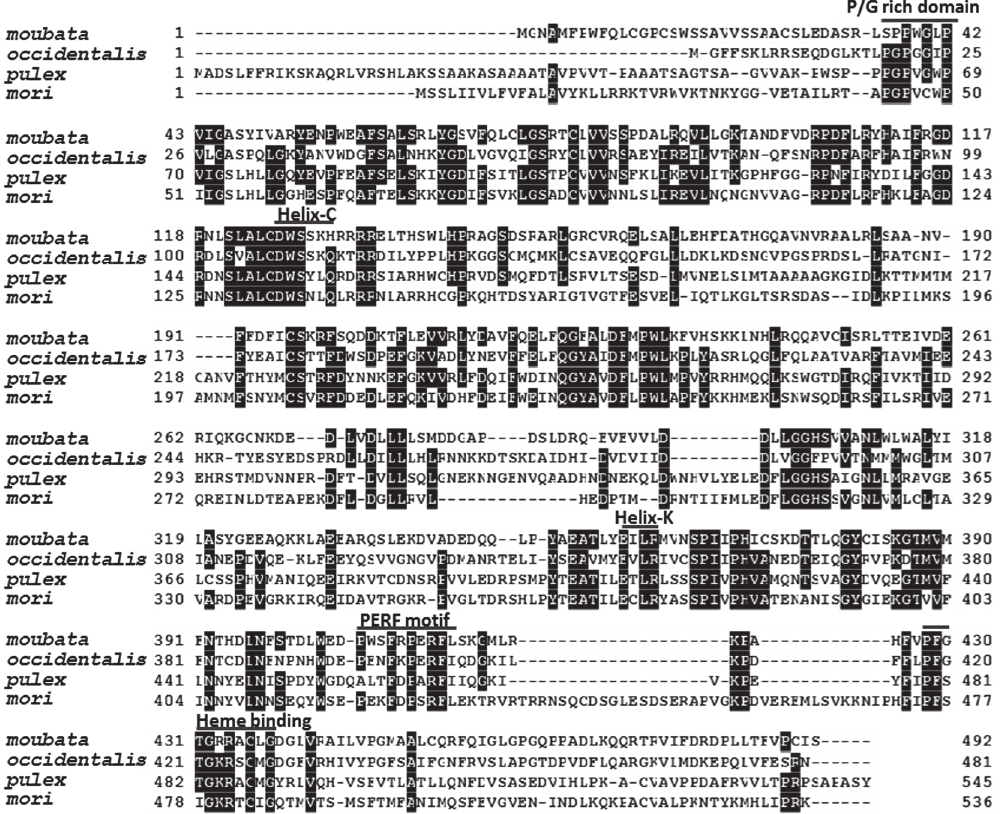
Fig 1. Multiple alignment of OmSpo with orthologs determined for other arthropods. Location of a P/G rich domain, Helixes (Helix-C and Helix-K), a PERF motif and a Heme binding domain are indicated